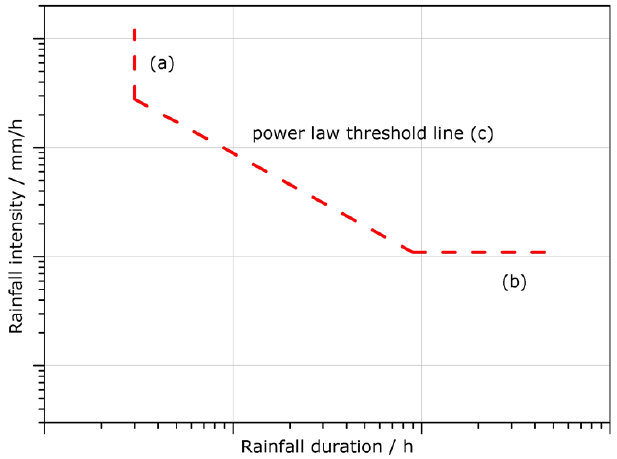
Fig. 7. Schematic illustration of the power law threshold line (c) (Eq. 1) and the intensity–dominated and duration-dominated do- mains delimited by the line of constant duration (a) and the line of constant mean intensity (b) ,